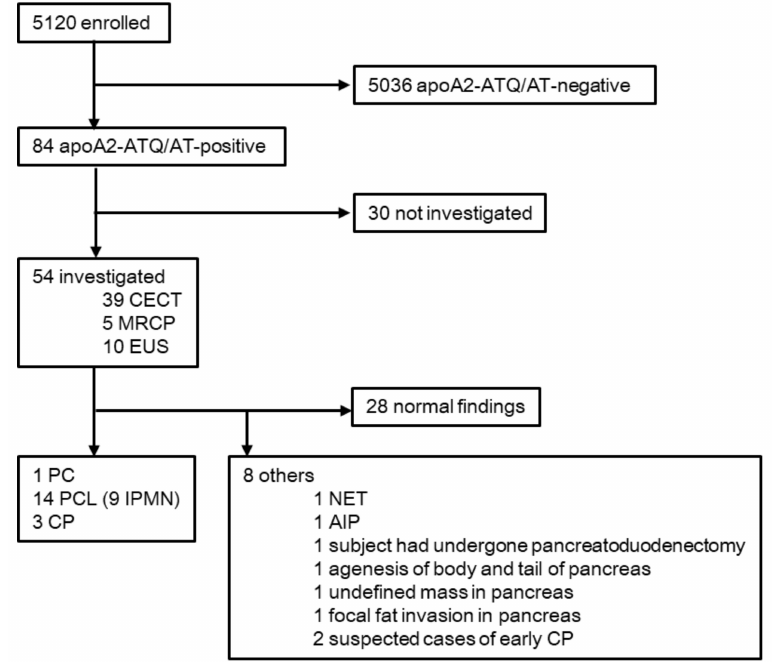
Figure 1. Flow diagram of the screening study. All subjects had plasma apoA2-ATQ / AT levels determined. The apoA2-ATQ / AT cut-o ff for a positive value was ≤ 35 µ g / mL. CECT, contrast-enhanced computed tomography; MRCP, magnetic resonance cholangiopancreatography; EUS, endoscopic